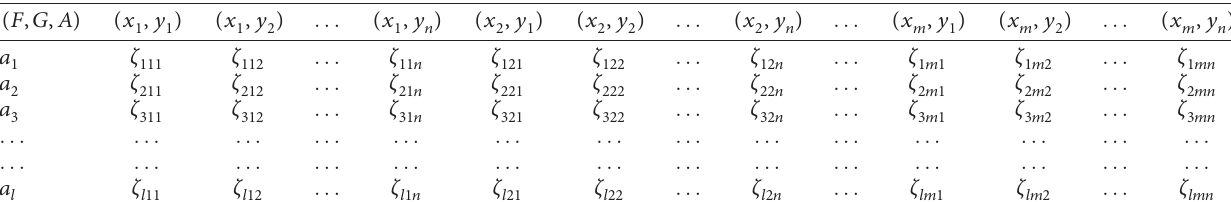
Table 1: Tabular form of a T-bipolar soft set.